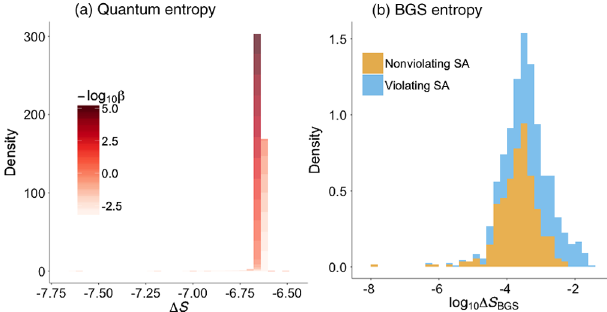
FIG. 3. Subadditivity of spectral entropy. Distribution of en- tropy variation (see the text) for an Erdös-Rényi network with p 0 . 01 and N ¼ 100 . The results for the quantum entropy link ¼ defined in this work (left-hand panel) and the BGS entropy (right-hand panel) are shown. Quantum entropy never violates subadditivity, regardless of the β parameter, whereas the BGS entropy significantly violates